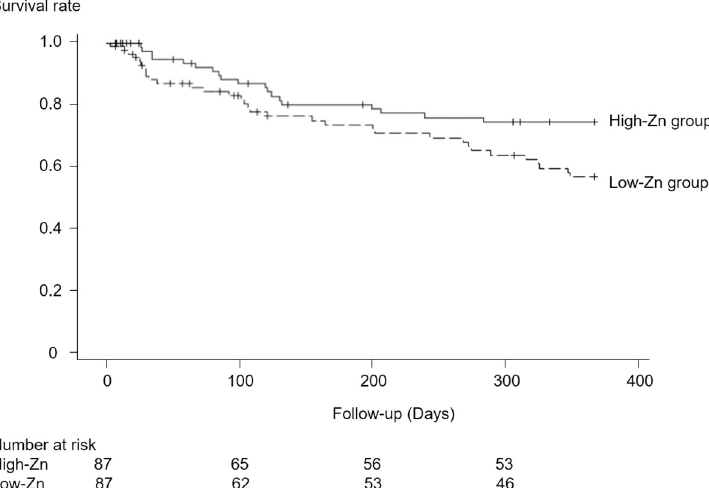
Fig 4. Survival rates in the propensity score-matched population. Kaplan-Meier curves for the primary outcome over 1 year.